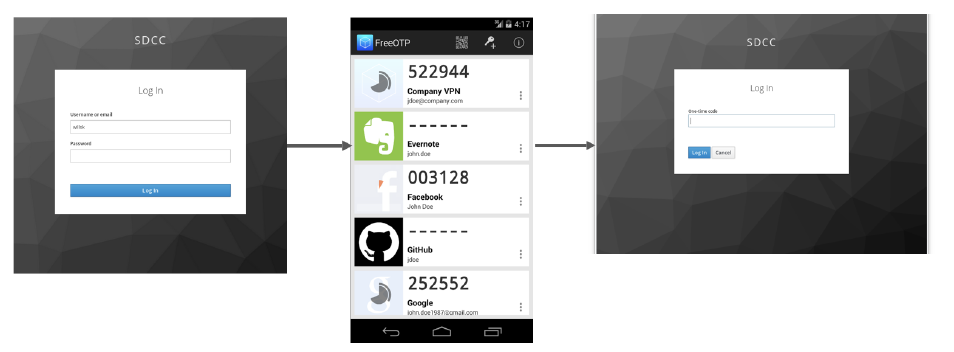
Figure 3. Illustration of the multi-factor authentication process for accessing the SDCC analysis portal.